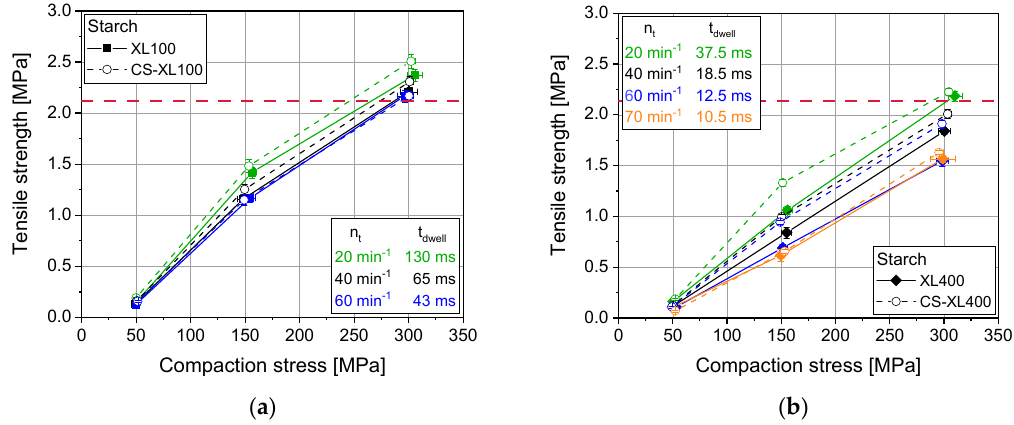
Figure 3. Tabletability profile for starch on XL100 ( a ) and XL400 ( b ) as well as for their simulation profiles applied on a CS. Red dashed line presents a guide to the eye for comparable results at comparable dwell time (approx. 40 ms) at approx. 300 MPa on both rotary press scales, applying 14 mm punches, respectively. n =